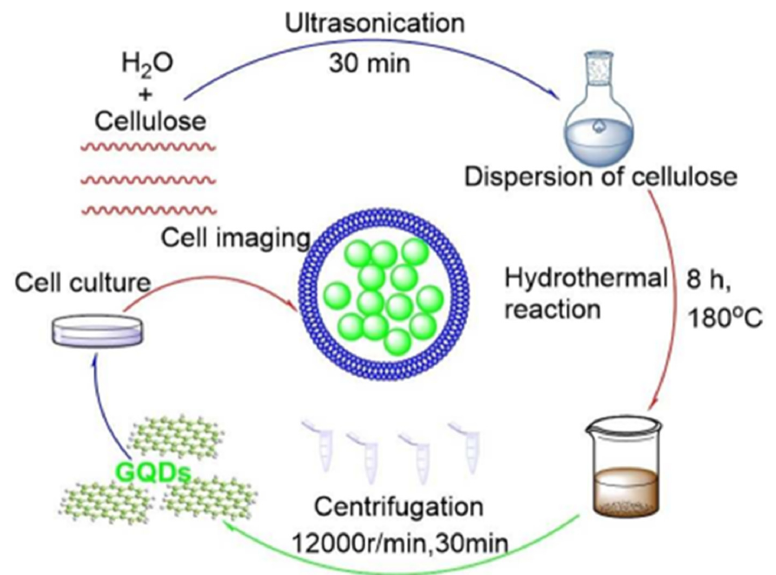
Figure 7. The renewable pathway for eco-friendly synthesis of GQD. “Reproduced with permission from [92], [ChemistrySelect]; published by Wiley, 2019”. from [92], [ChemistrySelect]; published by Wiley,